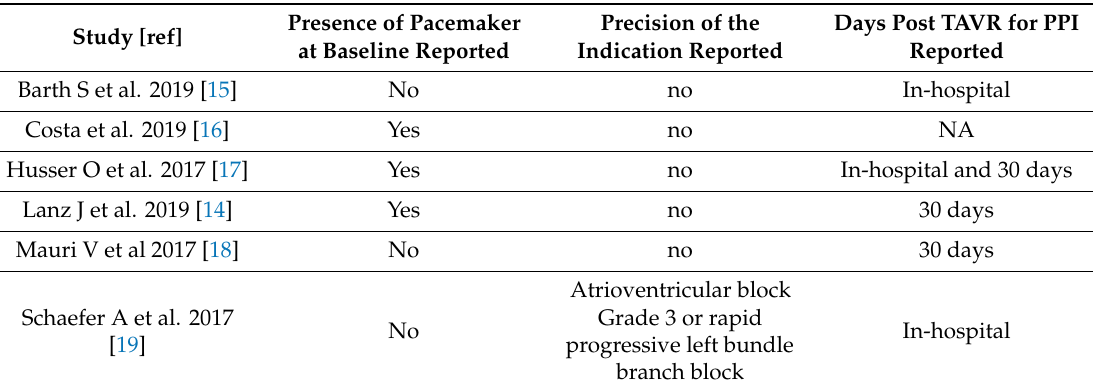
Table A6. VARC-2 derived permanent pacemaker implantation criteria quality appraisal.